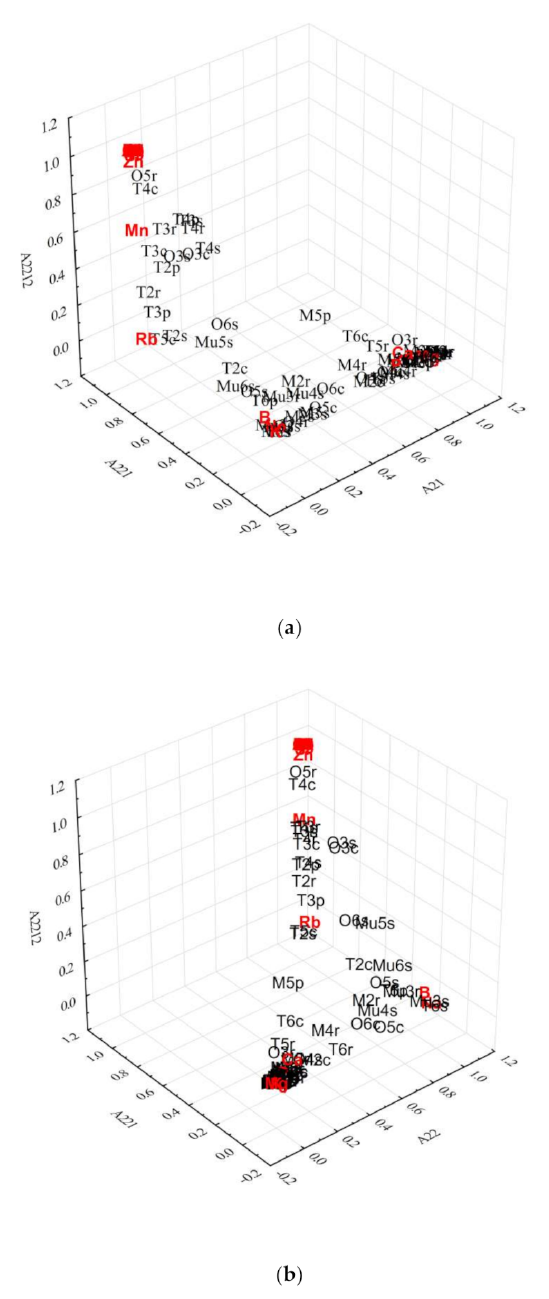
Figure 1. 3D bi-plot of DOMs corresponding to fuzzy partitions ( a ) A21, A221 and A2212 and ( b ) A22, A221 and